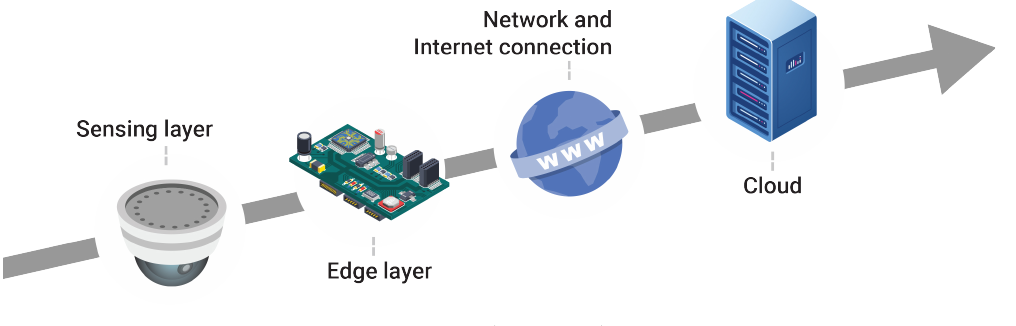
Figure 2. The IoT